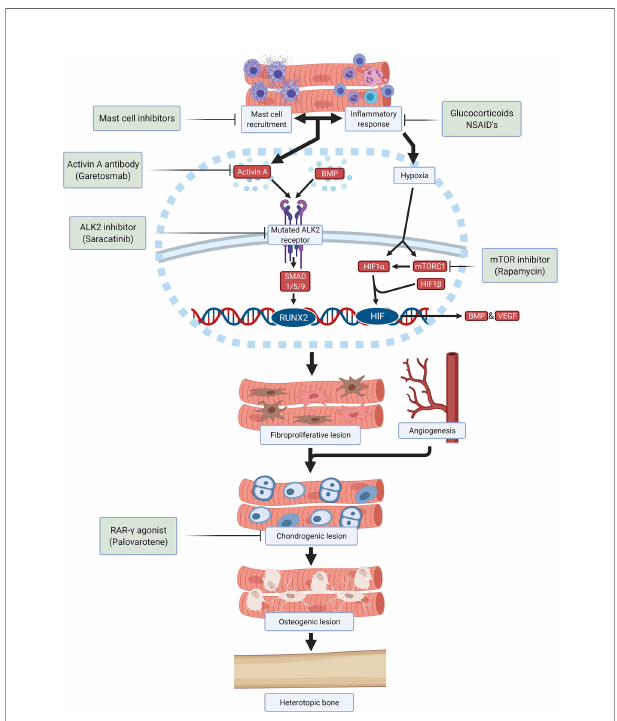
FIGURE 2 | Schematic overview of drugs and investigational compounds currently used and/or evaluated in FOP treatment and their respective